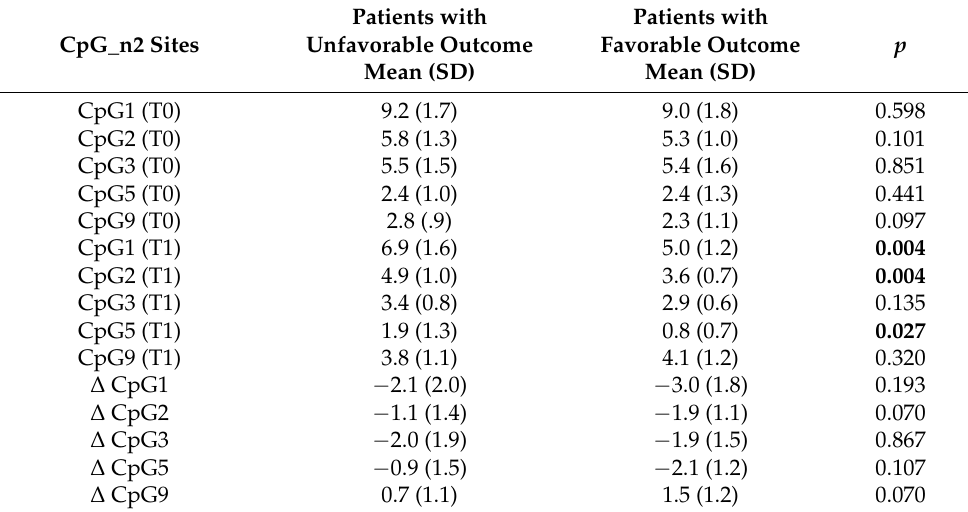
Table 3. Methylation percentage comparison of the CpG_n2 island sites (CpG1, CpG2, CpG3, CpG4, CpG5)at baseline (T0), after rehabilitation treatment (T1) and their changes from baseline ( ∆ ) in patients with or without a favorable outcome (BI ≥ 75 at discharge). p values refer to the Mann– Whitney U test. Patients with CpG_n2 Sites Unfavorable